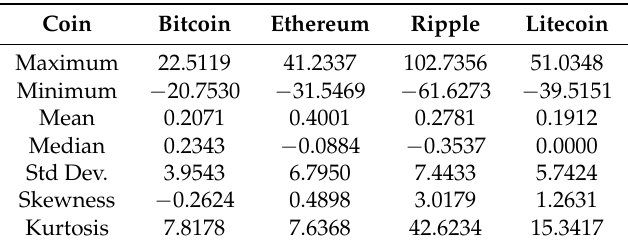
Table 1. Descriptive statistics, calculated between 8 August 2015 and 28 February 2019.